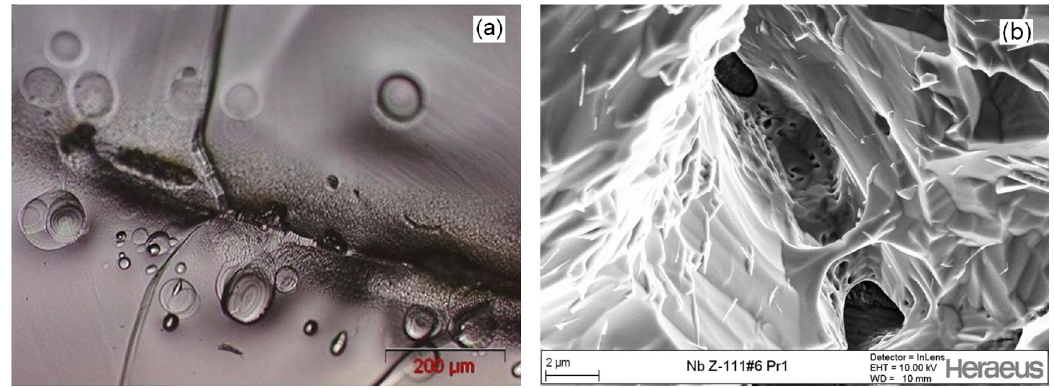
FIG. 11. (a) Light microscope image of the hot spot represented in Fig. 10(a); (b) magnified SEM image of holes represented in